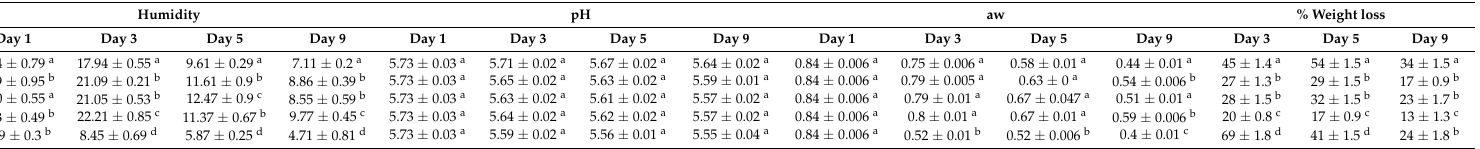
Reported values correspond to the mean ± standard deviation. Different letters in the same column indicate significant differences ( p <